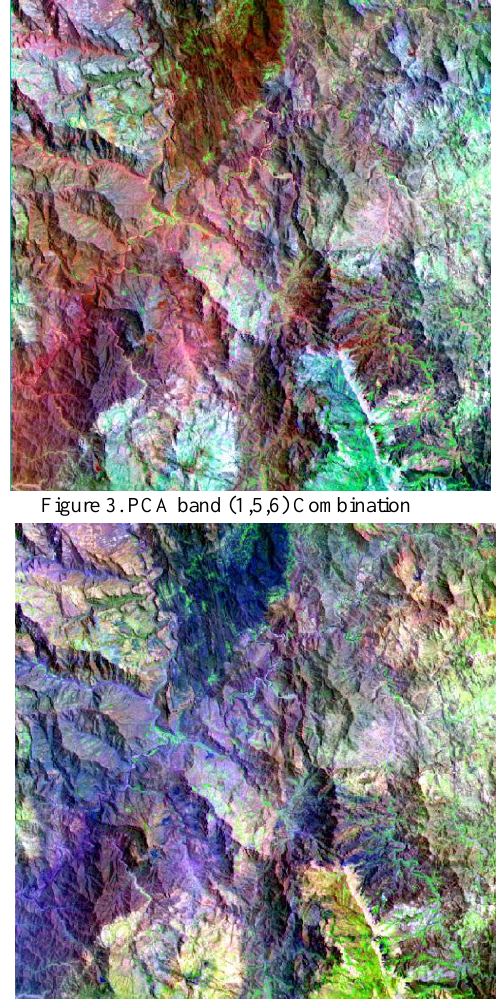
Figure 1. Geological map of the study area